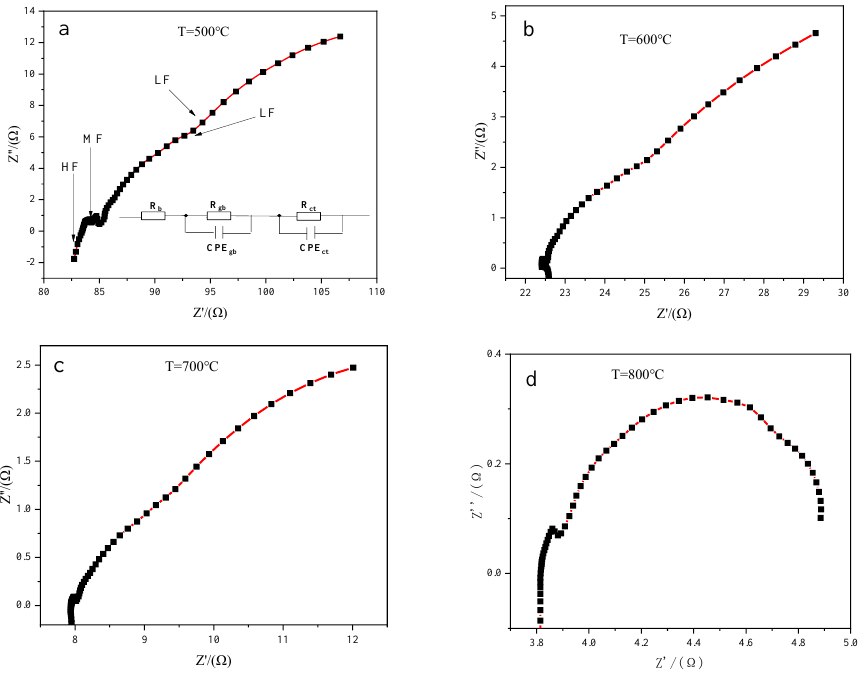
Figure 5. AC impedance graph of CSYG-15%BIT07 at different temperatures. ( a ) 500 °C, ( b ) 600 °C, ( c ) 700 °C and ( d ) 800 °C.